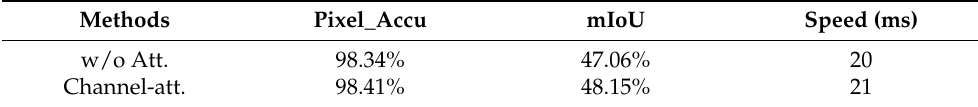
Table 3. Influence of CAM on pixel accuracy and